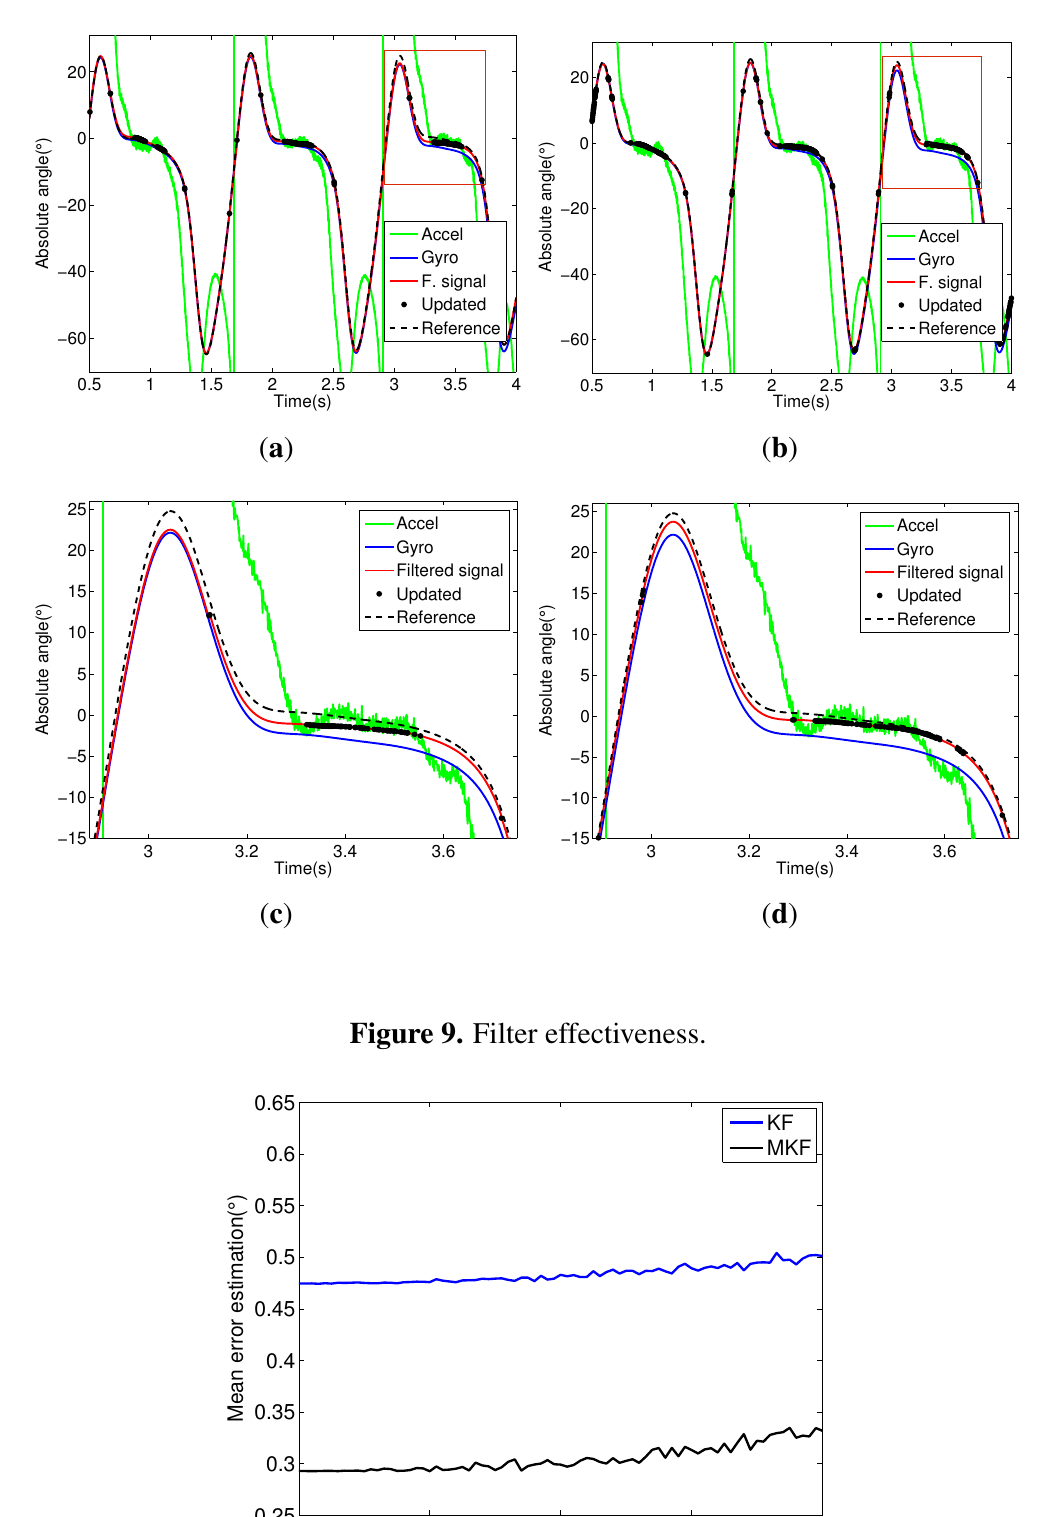
Figure 8. Foot segment. ( a ) KF signals; ( b ) MKF signals; ( c ) KF signals (zoom); ( d ) MKF signals (zoom).